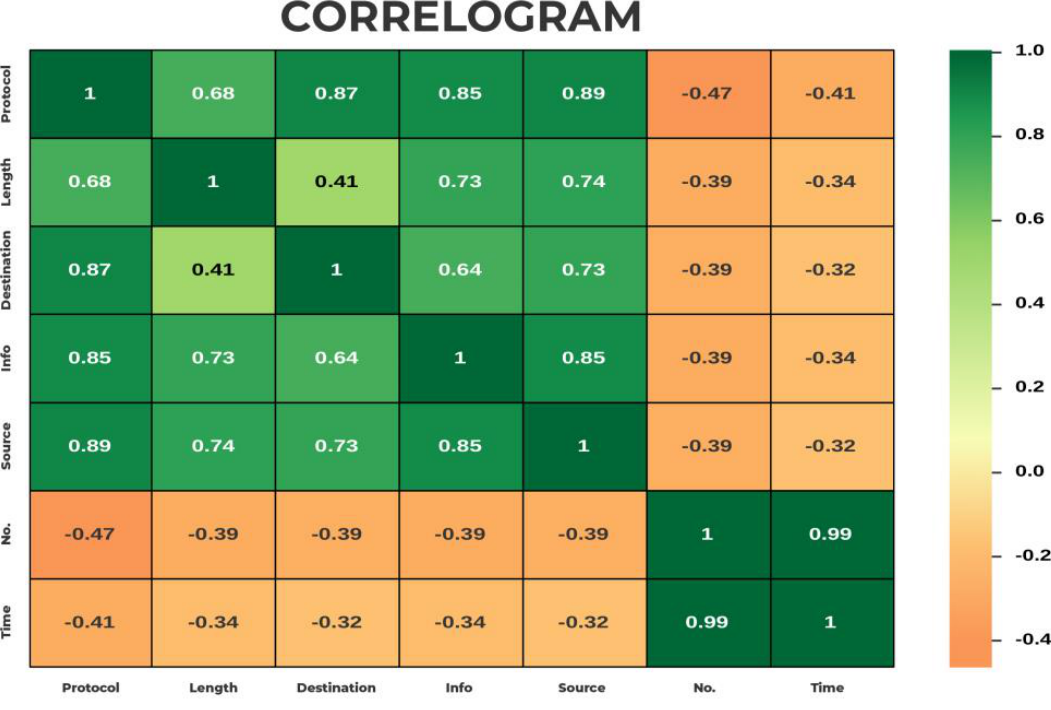
Figure 9. Correlogram.